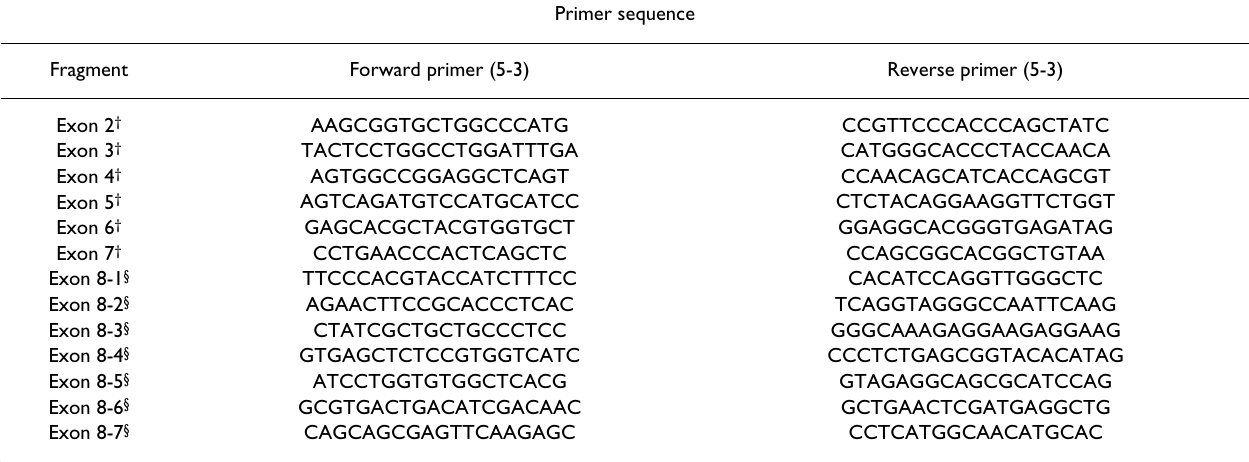
Table 1: Primers used in PCR/sequencing reaction of WFS1 coding region*